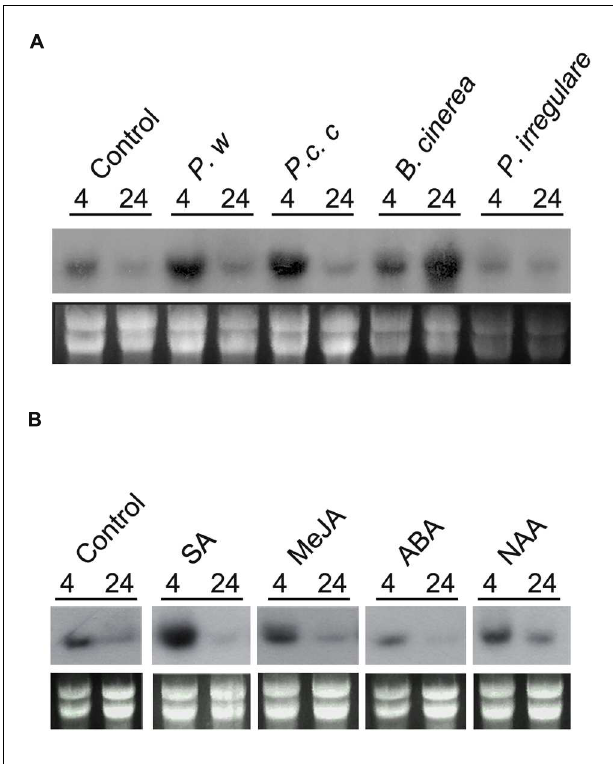
FIGURE 3 | PpPR-10 expression in response to pathogens and hormones. (A) Expression of PpPR-10 in response to elicitors of P. wasabiae ( P. w ) and P.c. carotovorum ( P.c.c ), spores of B. cinerea and mycelium of P. irregulare at different hours after treatments. As control colonies were treated with water. (B) Expression of PpPR-10 in moss colonies treated with SA, MeJA, ABA, and auxin 1-naphthalene acetic acid (NAA). Ten micrograms of total RNA were separated on formaldehyde–agarose gels, transferred to a nylon membrane and hybridized to a 32 P-labeled PpPR-10 cDNA probe. Ethidium bromide staining of rRNA was used to ensure equal loading of RNA samples. Experiments were repeated thrice with similar results.